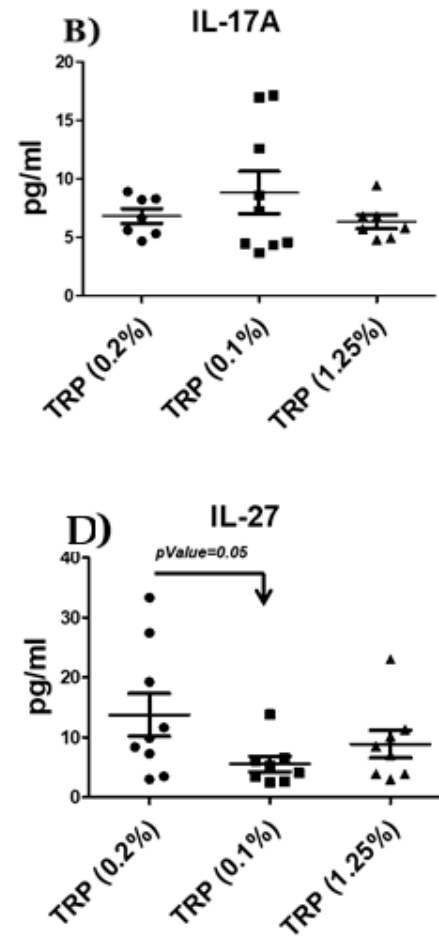
Figure 6. Serum cytokine levels in animals fed with a control diet, a TRP-deficient/low diet, and a TRP-rich diet. Serum was collected at the end of the experiment (week 8), followed by ELISA for immunoreactive ( A ) IL-6, ( B ) IL-17a ( C ) IL-1a, and ( D ) IL-27. Results are means ± SD ( n = 7–9/per group). Data were analyzed by ANOVA followed by Bonferroni post hoc test or t-test (* p < 0.05, # p < 0.01).